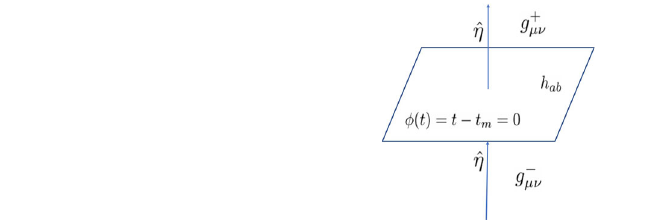
Fig. 5 Here, g + μν is contracting space–time and g − μν is the closed FLRW